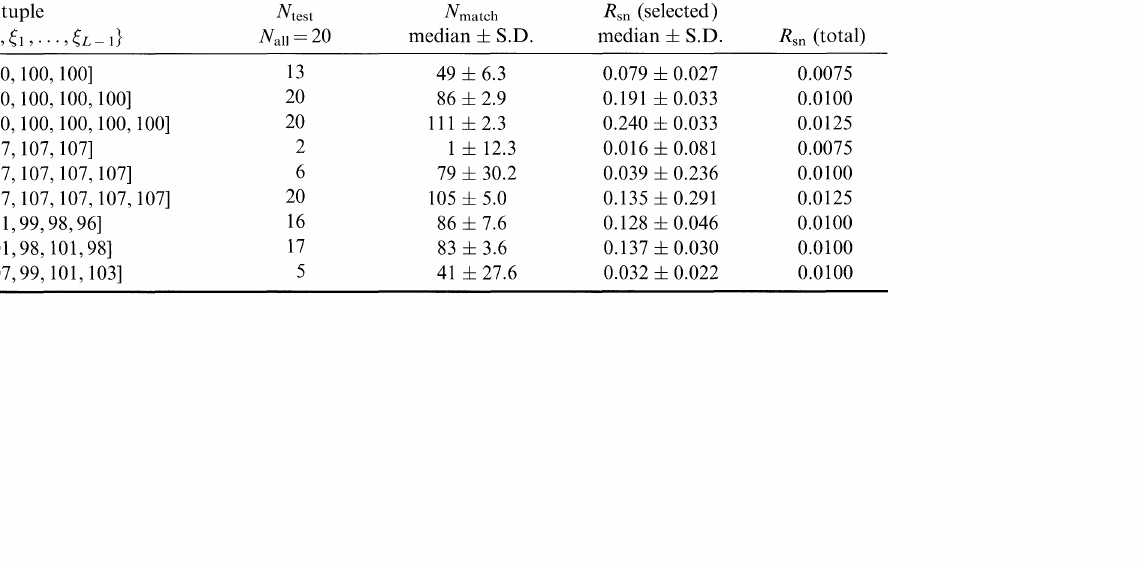
Results of the selection procedure for random time series in which u 25 sequences of x-values have been replaced by the -tuples given in column 1. For each type of -tuple Na- 20 independent time series have been generated. Ntest is the number of time series for which the test rejects 0, hence indicating non-random contributions. Nmatch is the number of those elements in the selected subseries matching (in both time and amplitude) with elements of the inserted -tuples. The medians and the standard deviations of Nmatch are listed. Rsn is the signal-to-noise ratio for the selected subseries and the total time series, respectively. For the selected subseries the medians and the standard deviations are listed as well L-